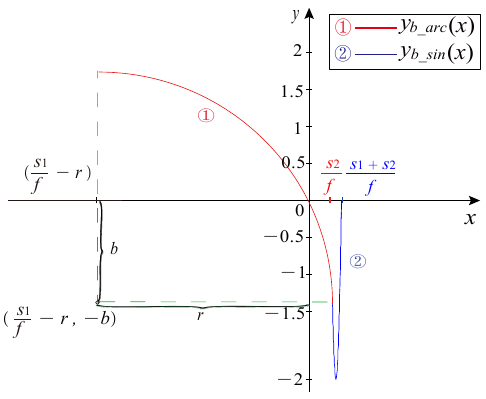
Figure 9. The first half of the missing waveform.